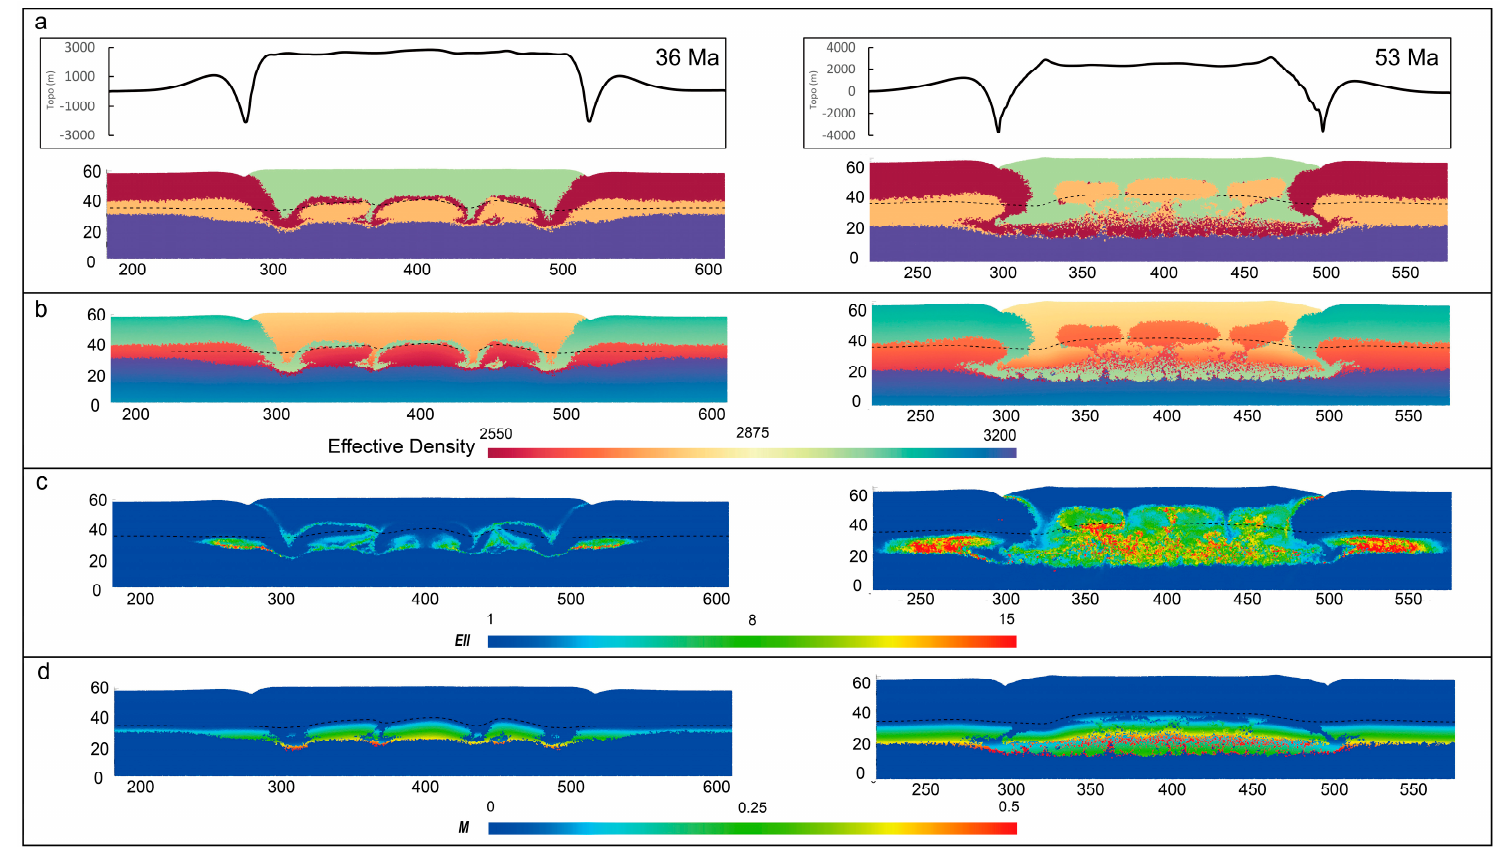
Figure 10. Model350, the width of sediment is set to 350 km. The solidus temperature of the lower crust is shown in dashed line. ( a ) At 36 Ma, less dense lower crustal rocks start to form three crustal-scale folds. Two-fold hinges are wider and preserve much more moderate-high pressure volcano-sedimentary rocks that that in case Model290. At 53 Ma, partially molten lower crustal rocks ascend into the sediment and form three diapirs. ( b ) Effective density is calculated by Equations (5) and (6). ( c ) The accumulation ( EII ) of the second invariant of the strain rate ( ε II , s − 1 ) is employed to identify shear zones over time (calculated by EII = ∑ t )). ( d ) Melt fraction is obtained by Equations (2) and (3).